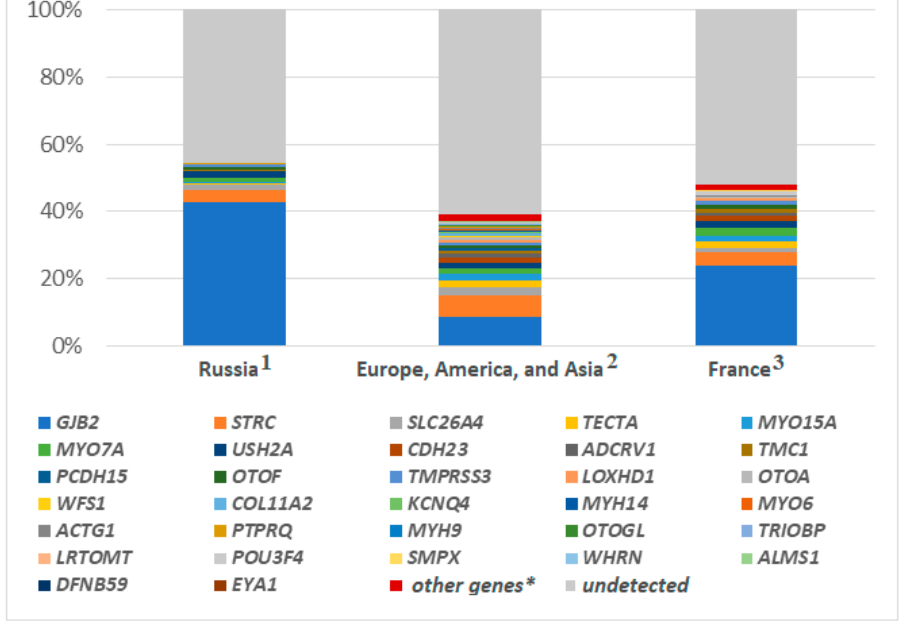
Figure 3. The contribution of the studied genes of the NSHL: 1—among Russian patients; 2—in a multi-ethnic sample of patients from Europe, America, and Asia [10] ; 3—in a sample of patients from France [11] ; *—genes not studied in this study. Table 2. The number of probands with NSHL with each of the identified genes of hearing loss among patients with an established molecular genetic diagnosis (n = 48). *—The comparison was made between the proportions in our cohort of Russian patients and the multi-ethnic sample of patients from Europe, America, and Asia from the study conducted by Sloan-Heggen et al. [10]. (95% CI)—confidence interval with the 95% confidence